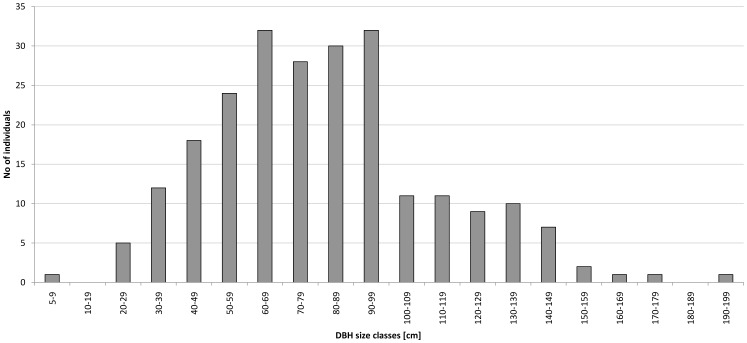
Histogram of diameter at breast height (DBH) of all the 235 enumerated adult Dysoxylum malabaricum trees within the 216 km2 study area.